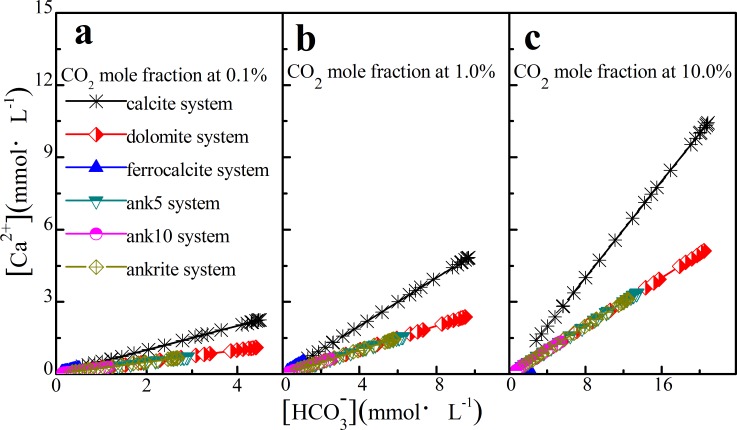
The linear relationship between [Ca2+] and [HCO3-].